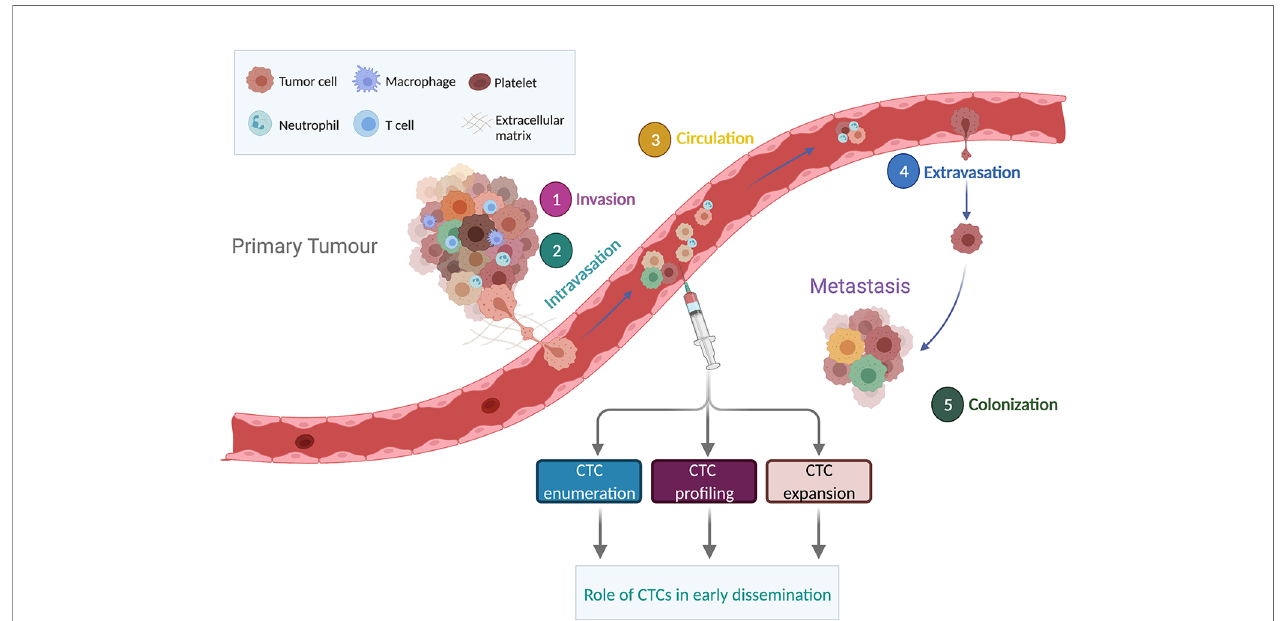
FIGURE 1 | Overview of the metastatic cascade. The metastatic process includes invasion, intravasation, circulation, extravasation and colonization. CTCs detaching from the primary tumor can travel alone or as clusters. Enumeration, molecular pro fi ling and expansion of CTCs in non-metastatic tumors could provide a better understanding on the signi fi cance of CTC early dissemination. Figure created in